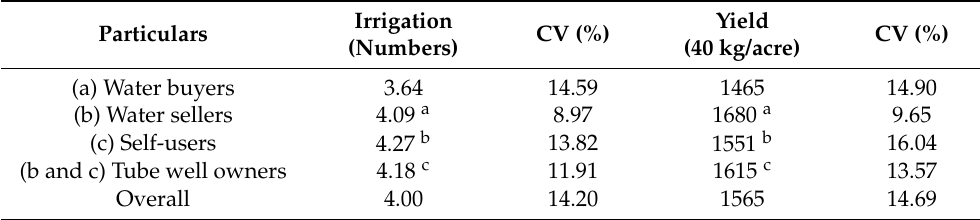
Table 3. Level of irrigation and wheat yield achieved under different water market regimes.